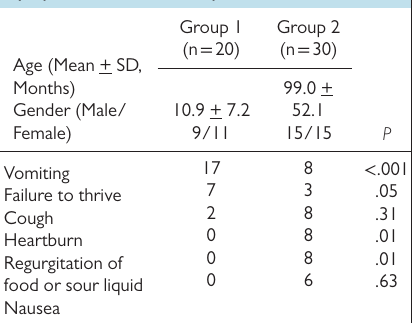
Table 1. Demographic Data of the Patients and Comparison of the Most